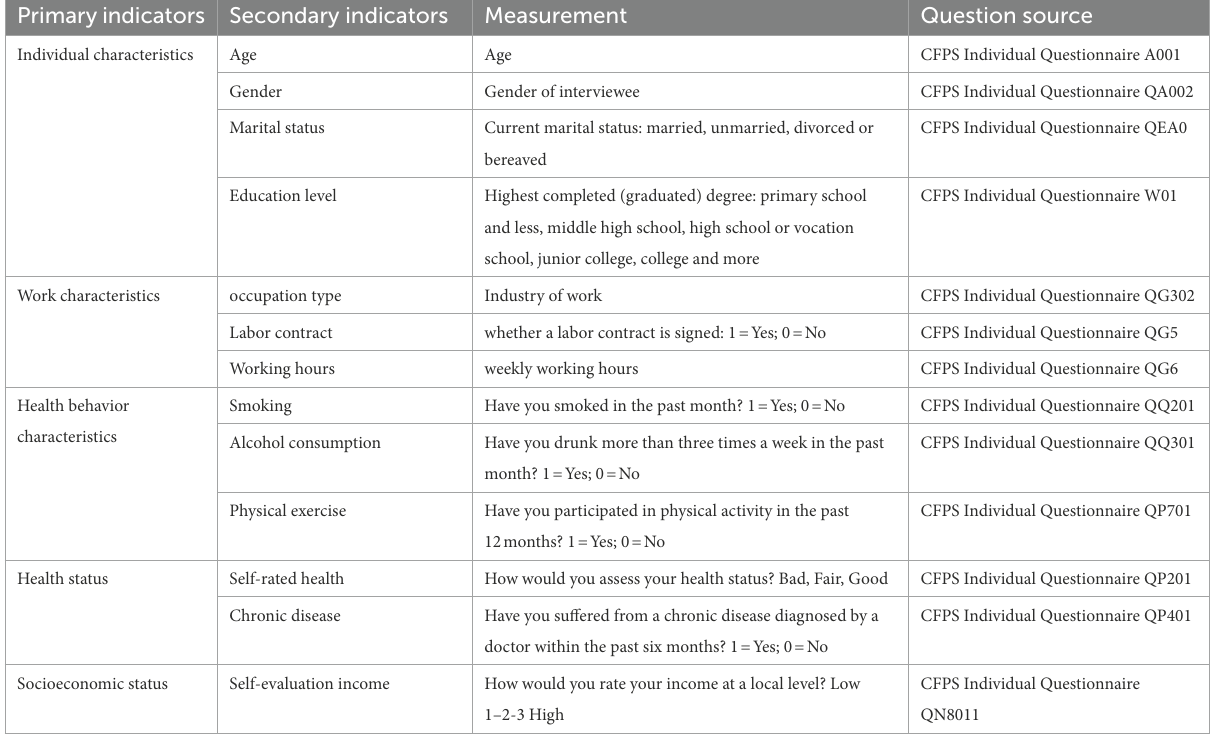
TABLE 1 Selection and measurement of control